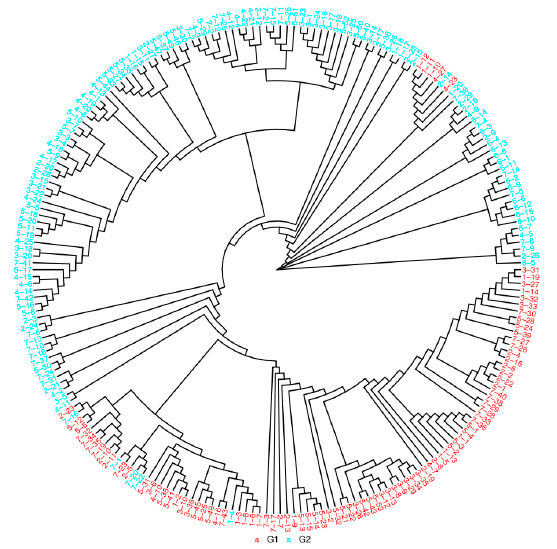
Figure 4. The phylogenetic tree. Phylogenetic tree generated by MEGA 7 illustrating the genetic relationship among 220 DXWR lines. G1: G1 subpopulations of DXWR, G2: G2 subpopulations of DXWR.